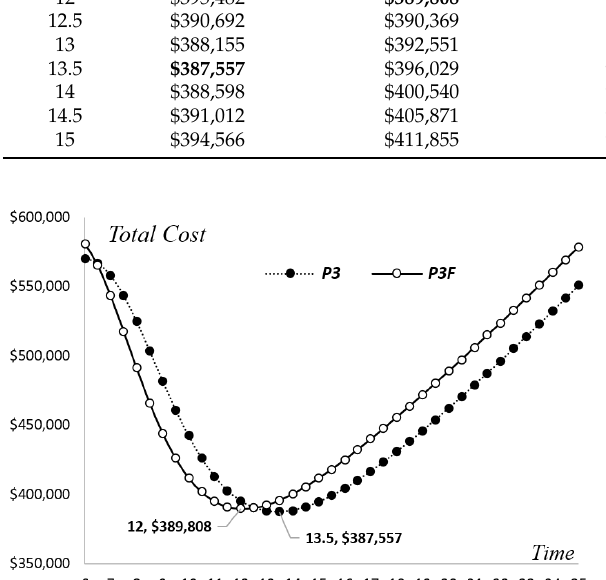
Figure 9. Total Expected Costs for the Former and the New Alternatives.